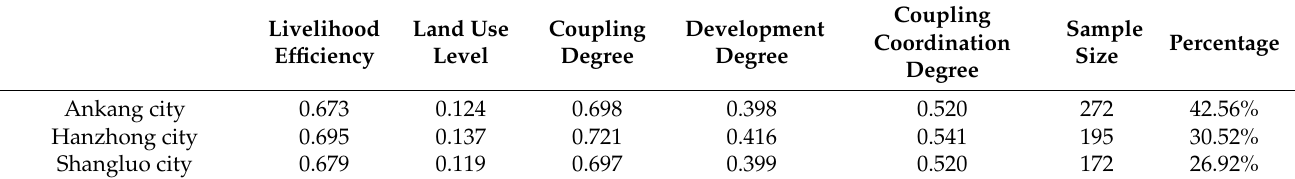
Table 7. Statistical results of the coupling coordination between household livelihood efficiency and land use in different regions